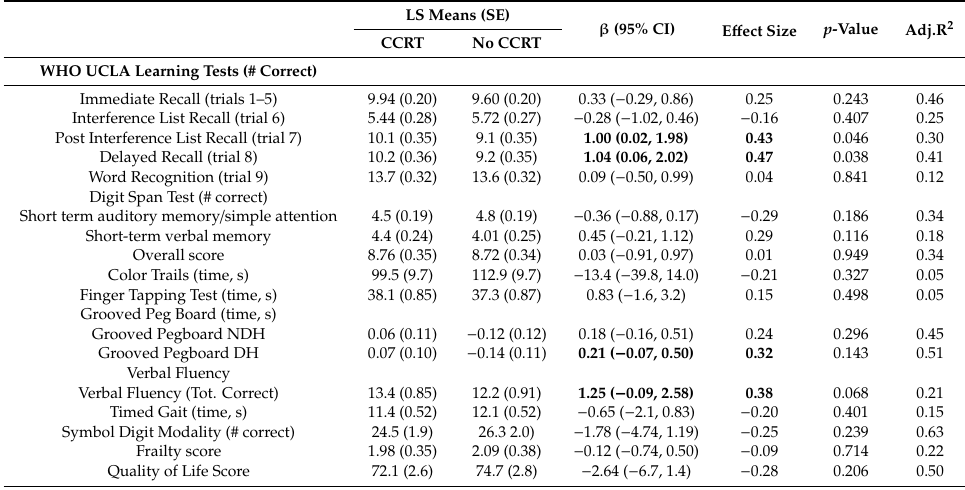
Table 3. Age, sex, HIV status, and education-adjusted e ff ect of CCRT vs. no CCRT intervention on performance in respective Neurocognitive Test